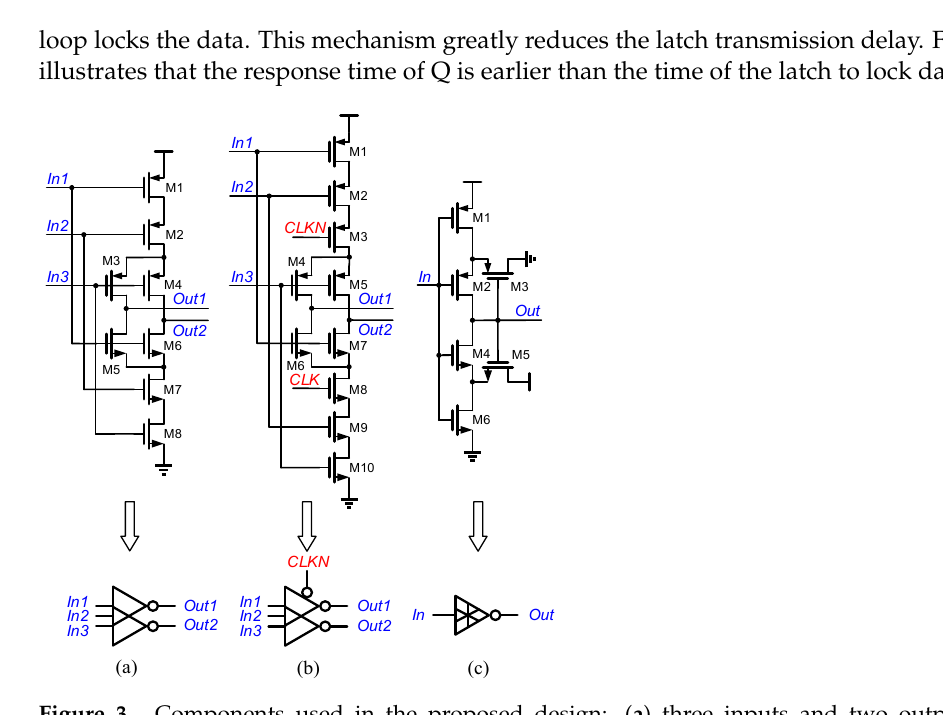
Figure 3. Components used in the proposed design: ( a ) three inputs and two outputs CE; ( b ) clock-controlled three inputs and two outputs CE; ( c ) Schmitt trigger.